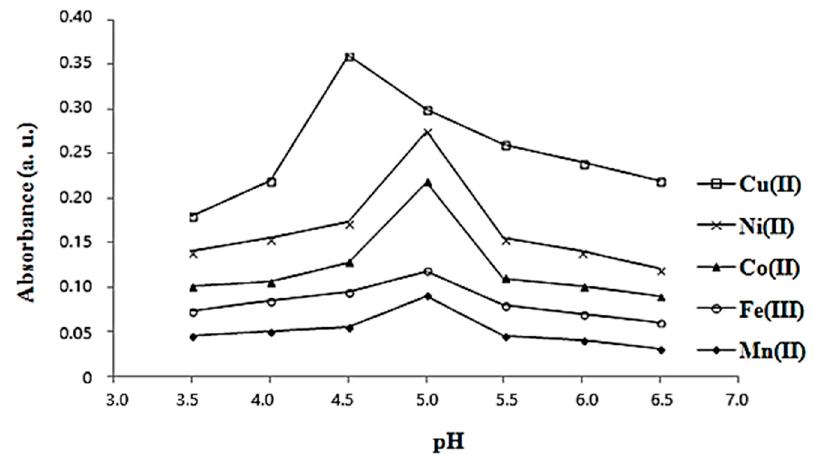
Figure 3. Determination of the optimal pH in synthesis for the complexes between ligand L and